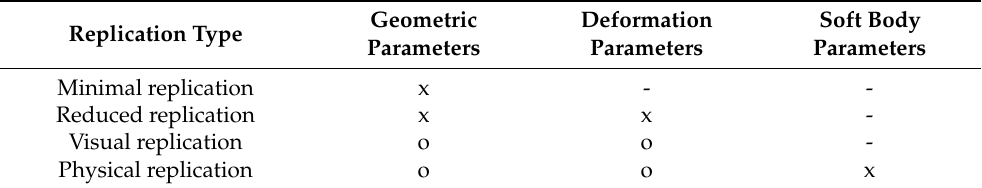
Figure 2. Applied replication types in overlapping scenarios. Table 1. Overview of the application of geometric, deformation and soft body parameters for the replication types with discrete values (x) and ranges of values